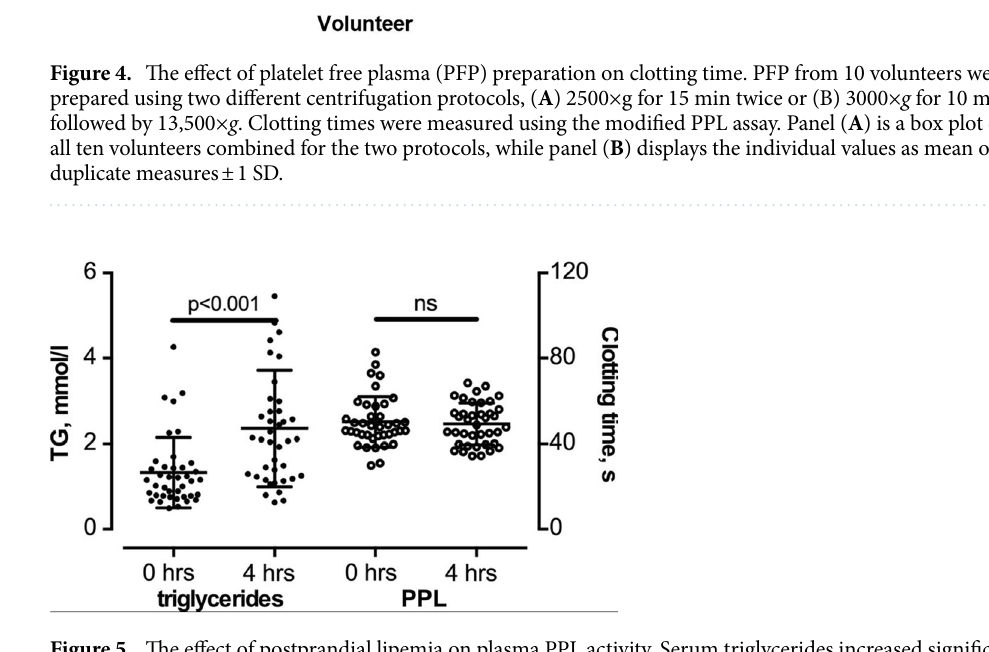
Figure 5. The effect of postprandial lipemia on plasma PPL activity. Serum triglycerides increased significantly after the ingestion of the standardized high fat meal without affecting the PPL activity. Dot plots are means ± 1 SD, n = 40 for each